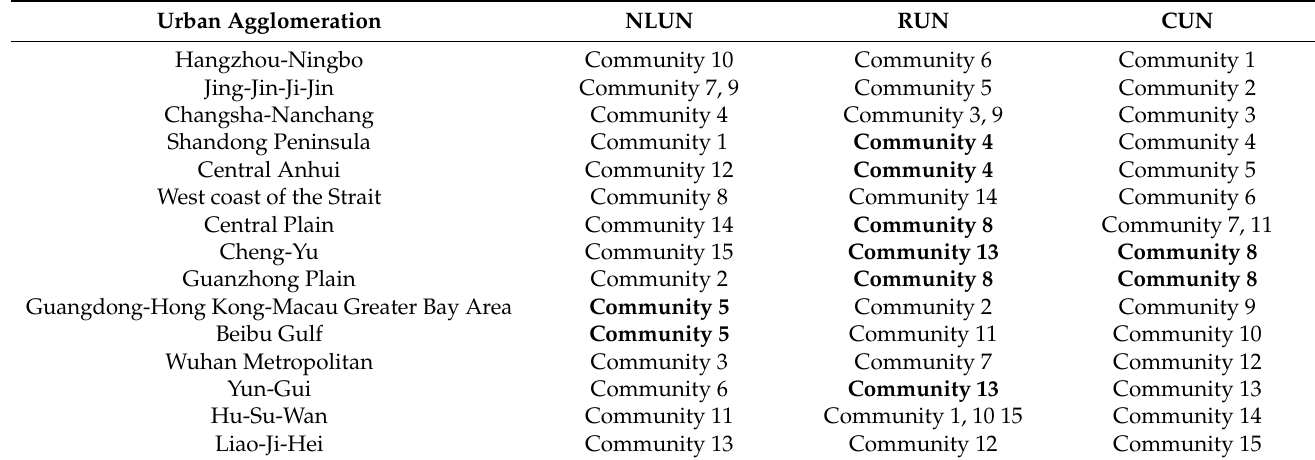
Table 2. The relationships between communities and urban